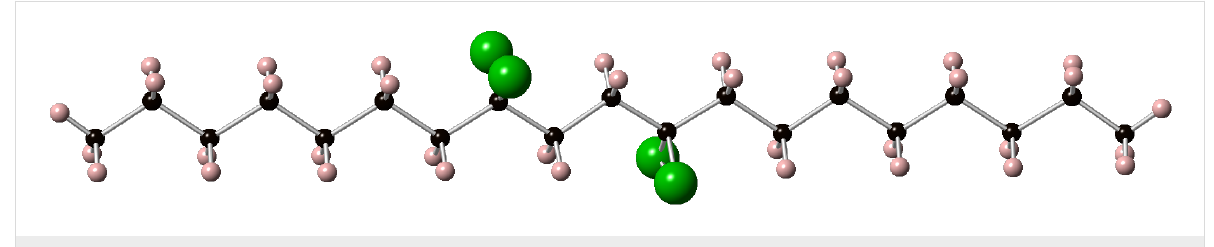
Figure 7: The X-ray structure of 8,8,11,11-tetrafluorononadecane ( 27 ).